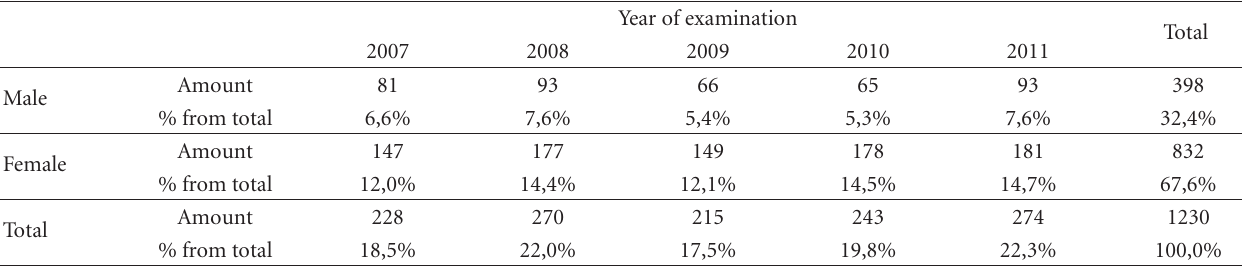
Table 2: Distributions of gender according to the year of